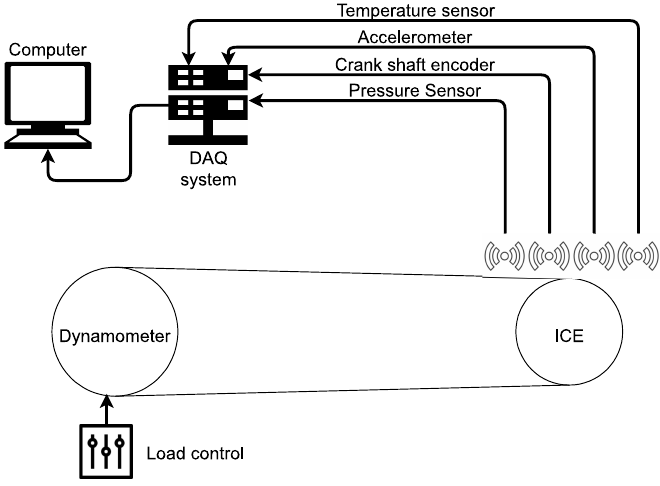
Figure 3. Test bench for recording signals from an internal combustion